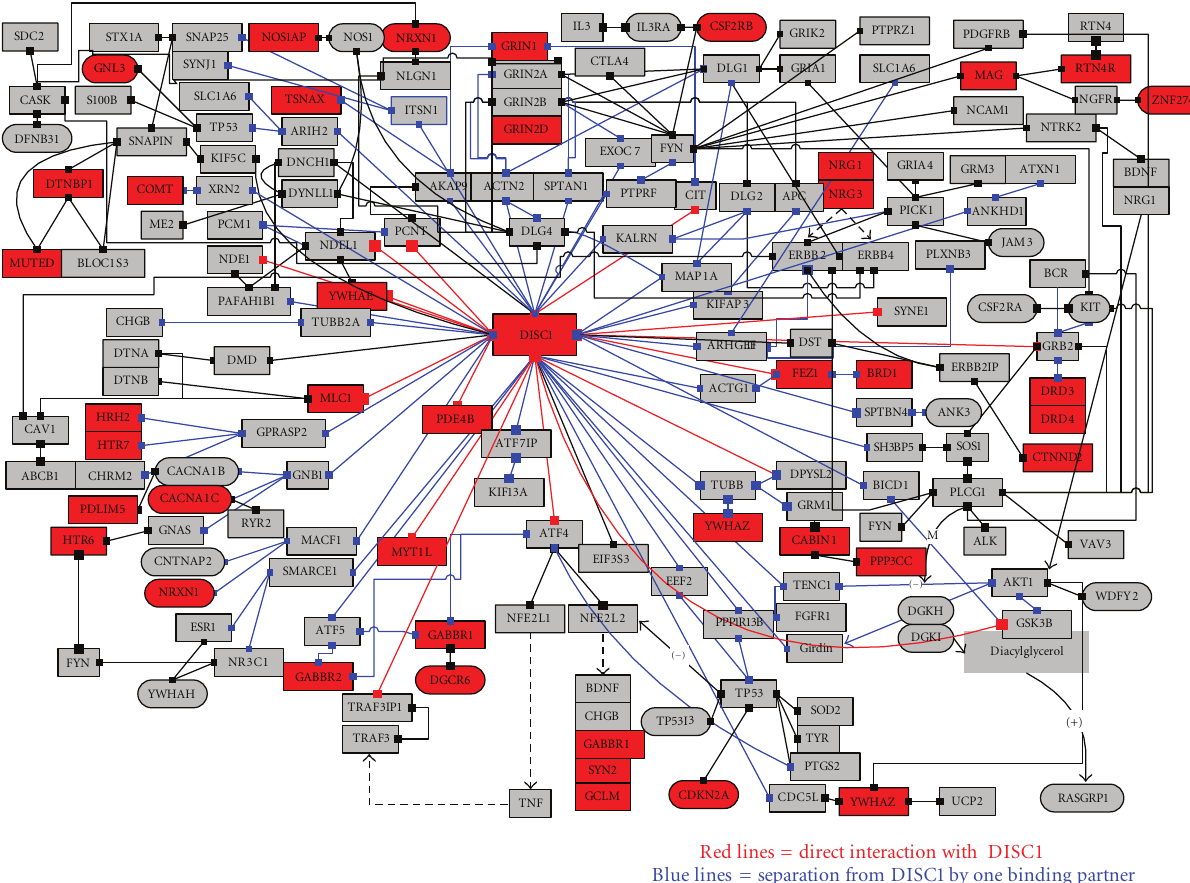
Figure 5: The DISC1 interactome see http://www.polygenicpathways.co.uk/discforum.htm. Proteins in red are homologous to Rubella